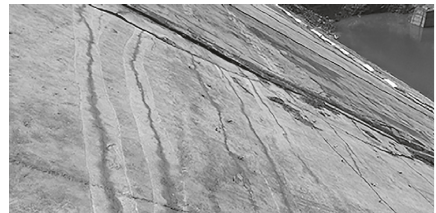
Figure 5: Horizontal fractures in the concrete-face slab.